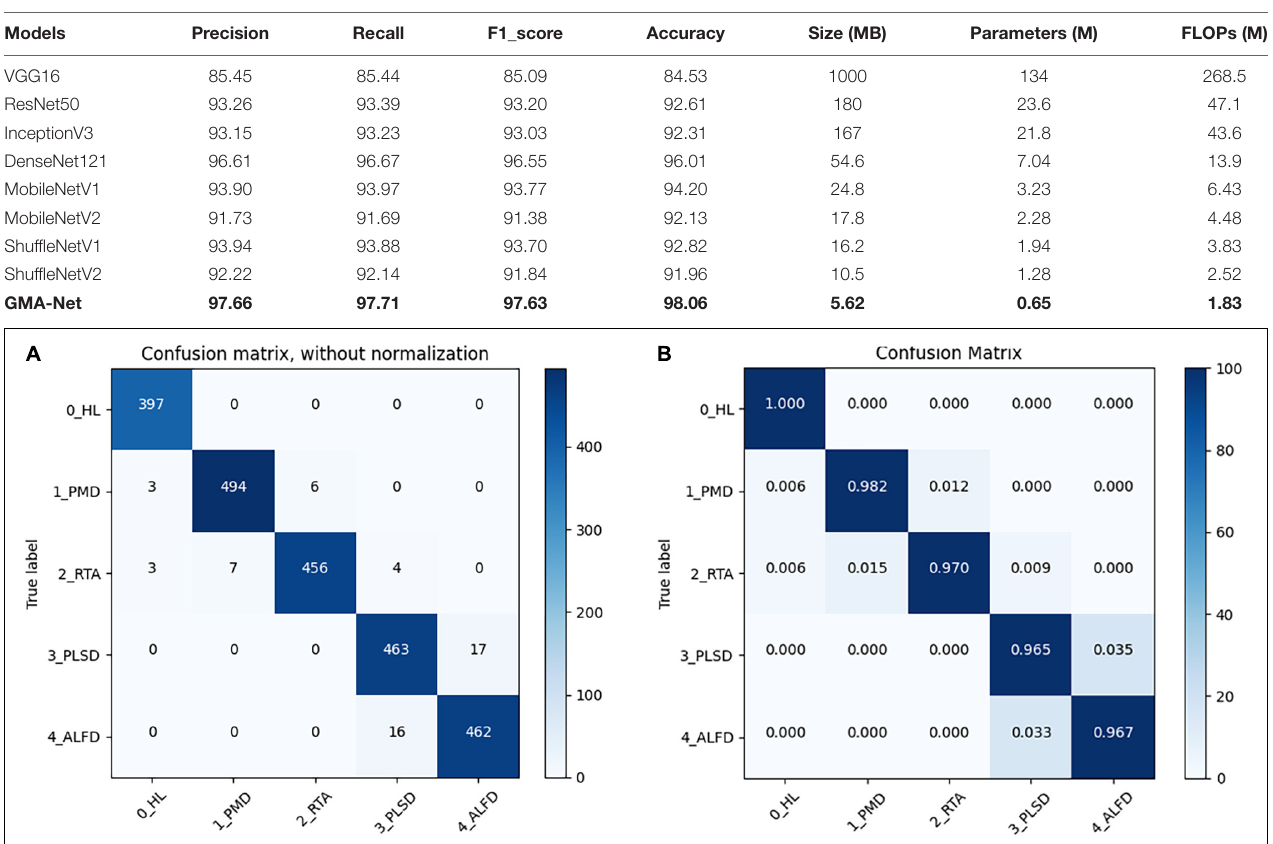
TABLE 4 | Comparison of the identification results of different CNN models.